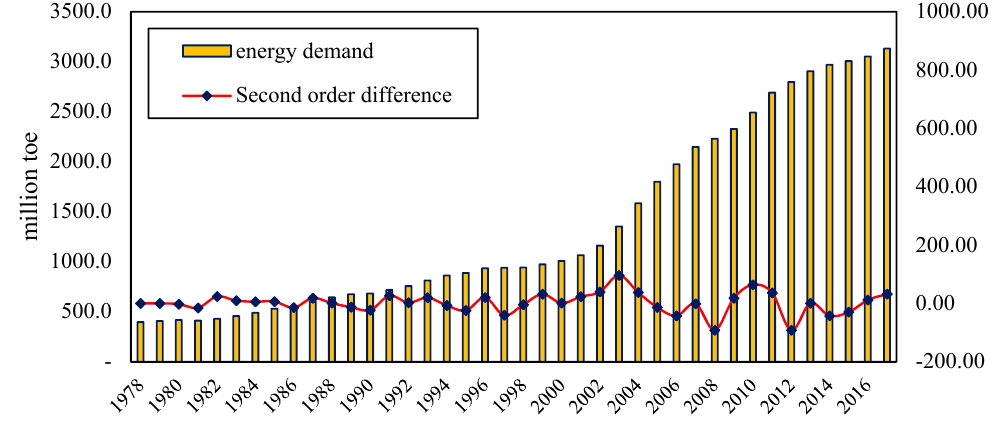
Figure 7. Primary energy demand time series from 1978 to 2017.